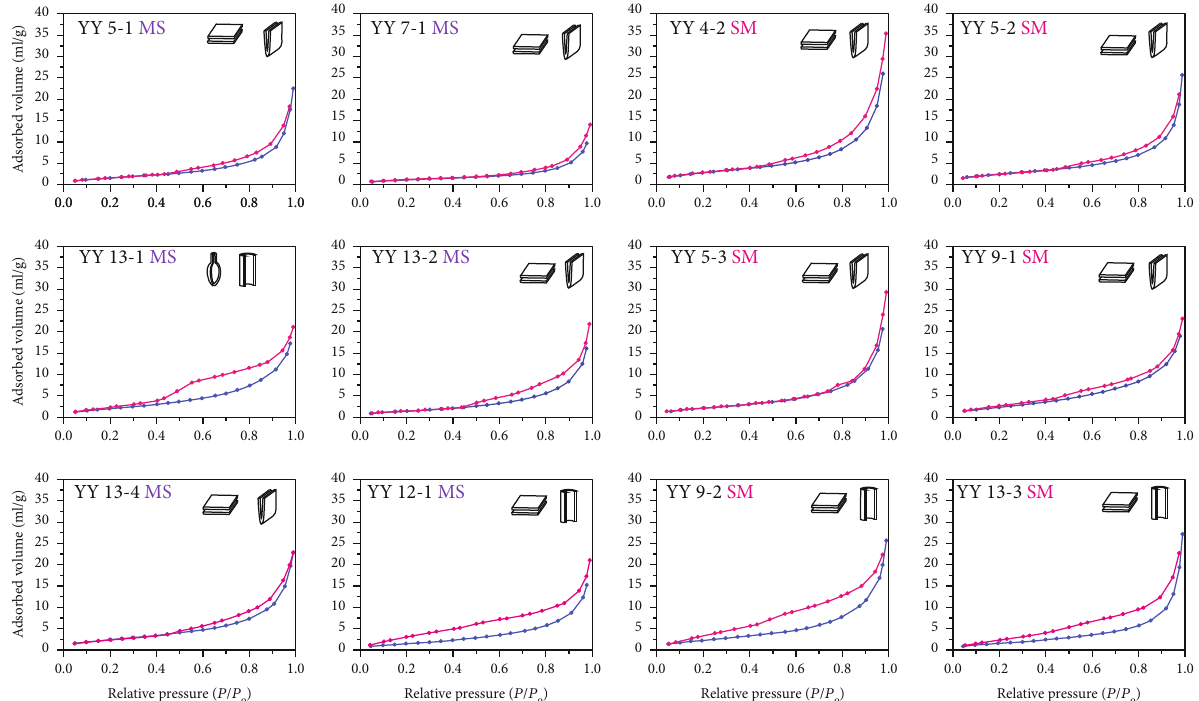
Figure 3: Low-pressure N